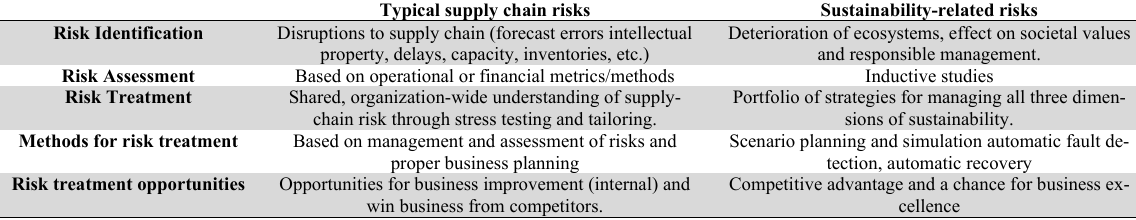
Risk management of typical vs. sustainability-related risks (Giannakis & Papadopoulos, 2016) Typical supply chain risks Sustainability-related risks Risk Identification Disruptions to supply chain (forecast errors intellectual property, delays, capacity, inventories, etc.)